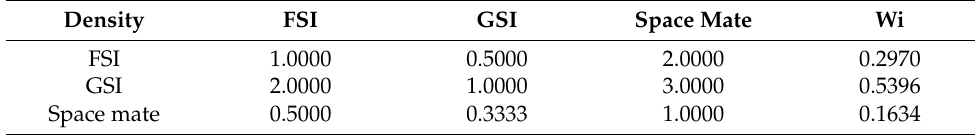
Table A9. Density Consistency ratio: 0.0088; Weight of “5D”: 0.4236; λ max: 3.0092.